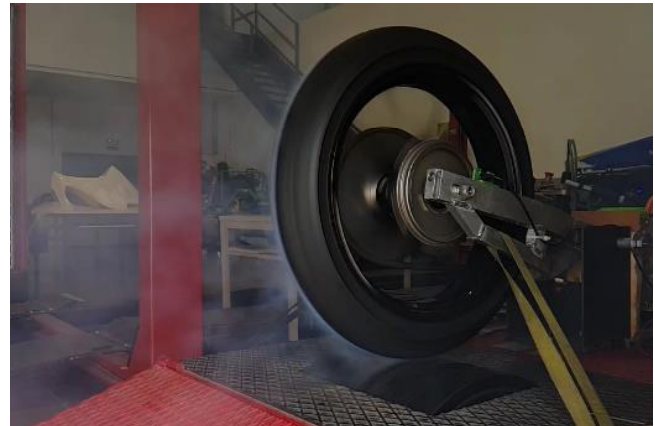
Figure A2. Burnout due to excessive slippage without TCS.